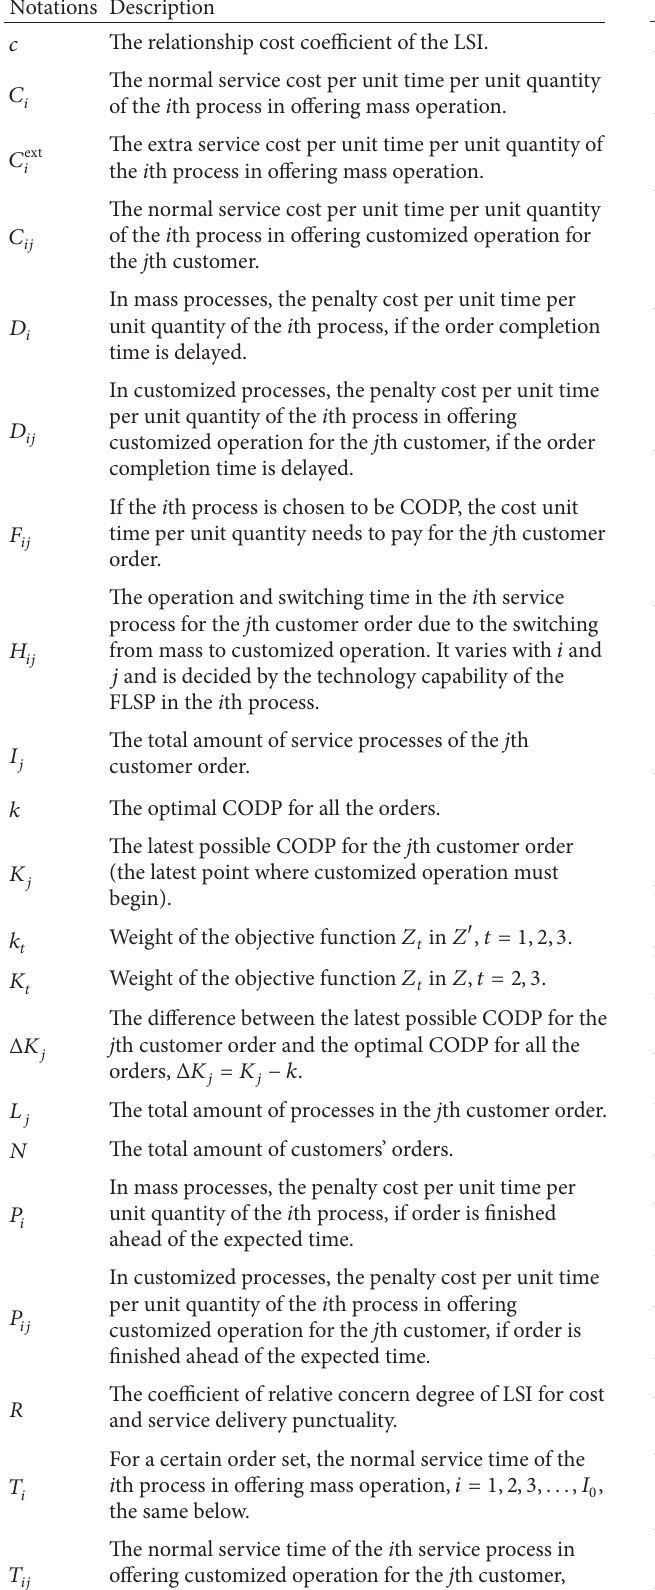
Table 1: Notations for the